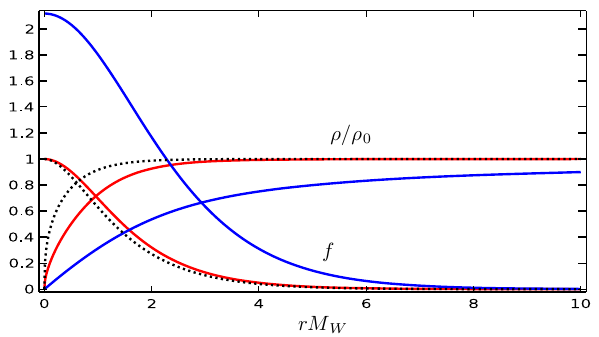
Fig. 3 The analytic electroweak monopole solution. The blue curves represent the analytic monopole given by (30) and the red curves rep- resent the finite energy electroweak monopole obtained by (21). The Cho–Maison monopole is shown in dotted curves for